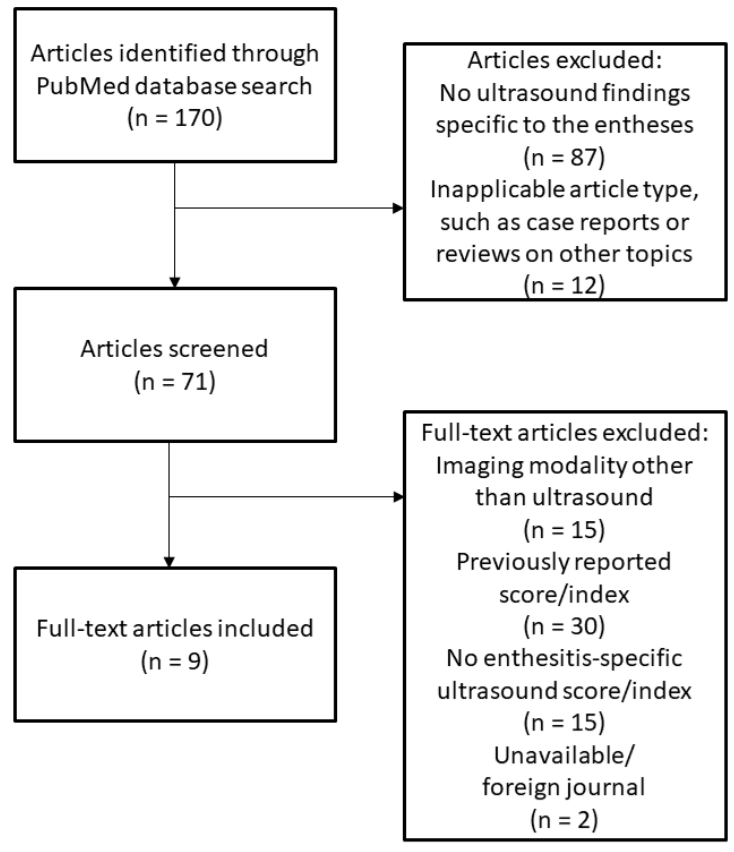
Figure 1. Literature Review Diagram.